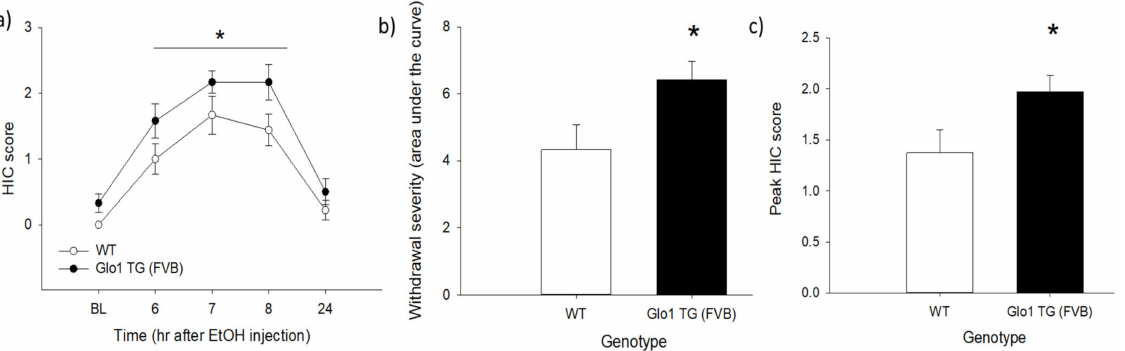
Figure 2. Acute ethanol withdrawal as assessed using HICs in wild-type (WT) and Glo1 -overexpressing (TG) mice on an FVB/NJ (FVB) genetic background. Panel ( a ) shows the time course of withdrawal, with baseline HIC measurements made immediately before the ethanol injection. There was a main effect of genotype, with Glo1 -overexpressing mice having higher HIC scores across the time course that WT mice. Glo1 -overexpressing mice also showed greater cumulative seizure susceptibility (area under the curve (AUC), panel ( b )), and higher peak HIC scores than WT littermates (panel ( c )). * indicates p < 0.05. n =